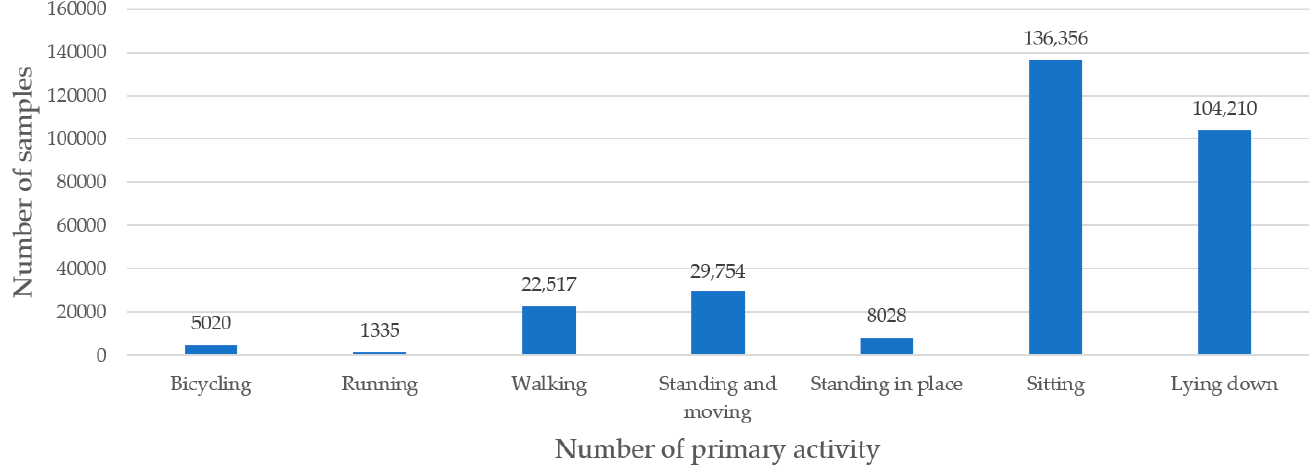
Figure 2. The number of samples of each of the primary activities. Table 2. Summary of the number of samples of the secondary activities.